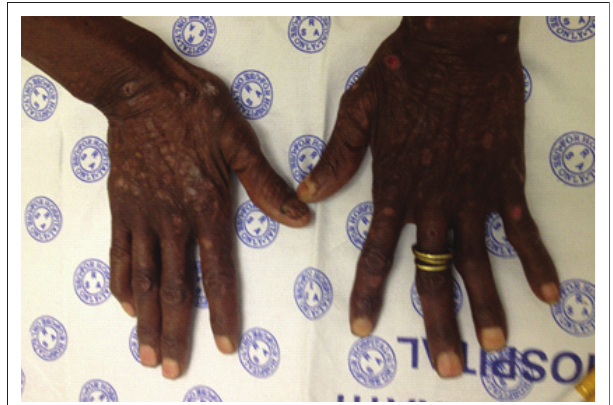
FIGURE 7: Porphyria cutanea tarda.